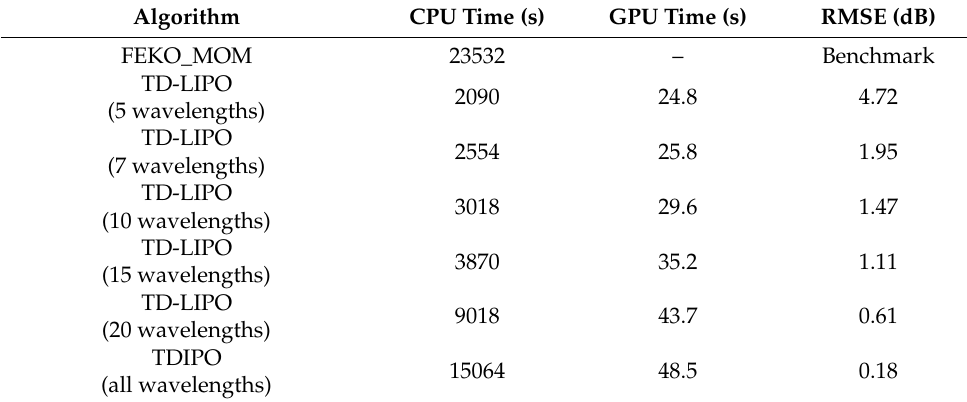
Table 2. The calculation time and accuracy of each